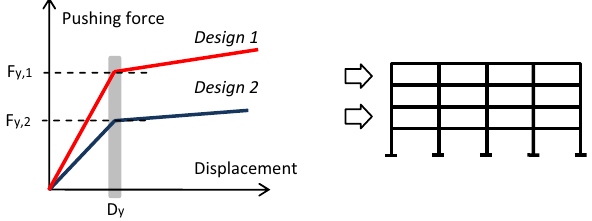
Fig. 1 Results of pushover analysis, for models that differ only in component reinforcement